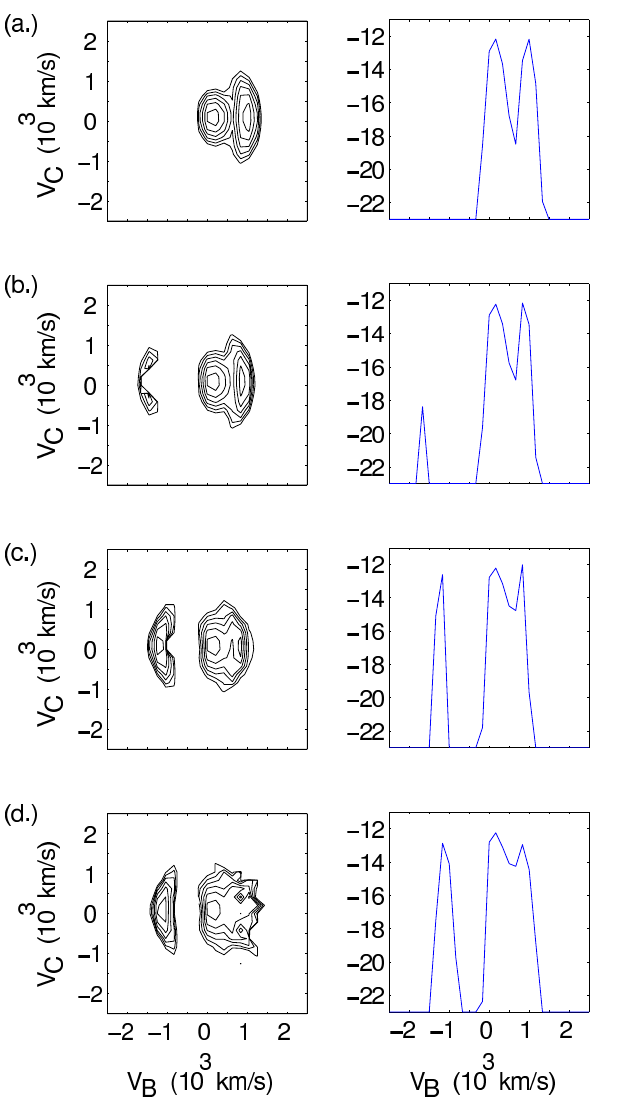
Fig. 10. Model ion velocity distributions shown as (left column) two-dimensional distributions in the V B - V C plane, and (right col- umn) cuts in the V B direction ( V C =0) at four locations in the noon- midnight meridian, (a) Z=3.2, (b) 2.25, (c) 0.75, and (d) 0.3 R E , all at X =-20 R E .